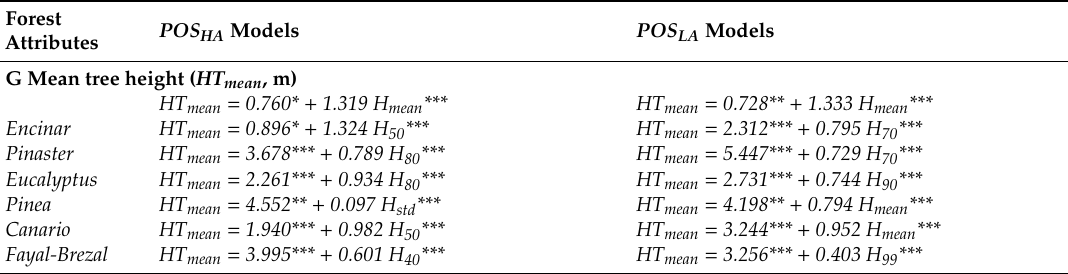
Table A1. Model composition, including coefficients, predictor variables and the level of significance. The models were fitted using low-accuracy measurements positioning ( POS lA ) and high-accuracy measurements positioning ( POS HA ).